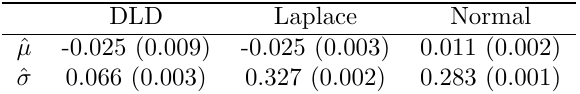
Application - maximum likelihood estimates and their asymptotical standard deviations for DLD, Laplace and